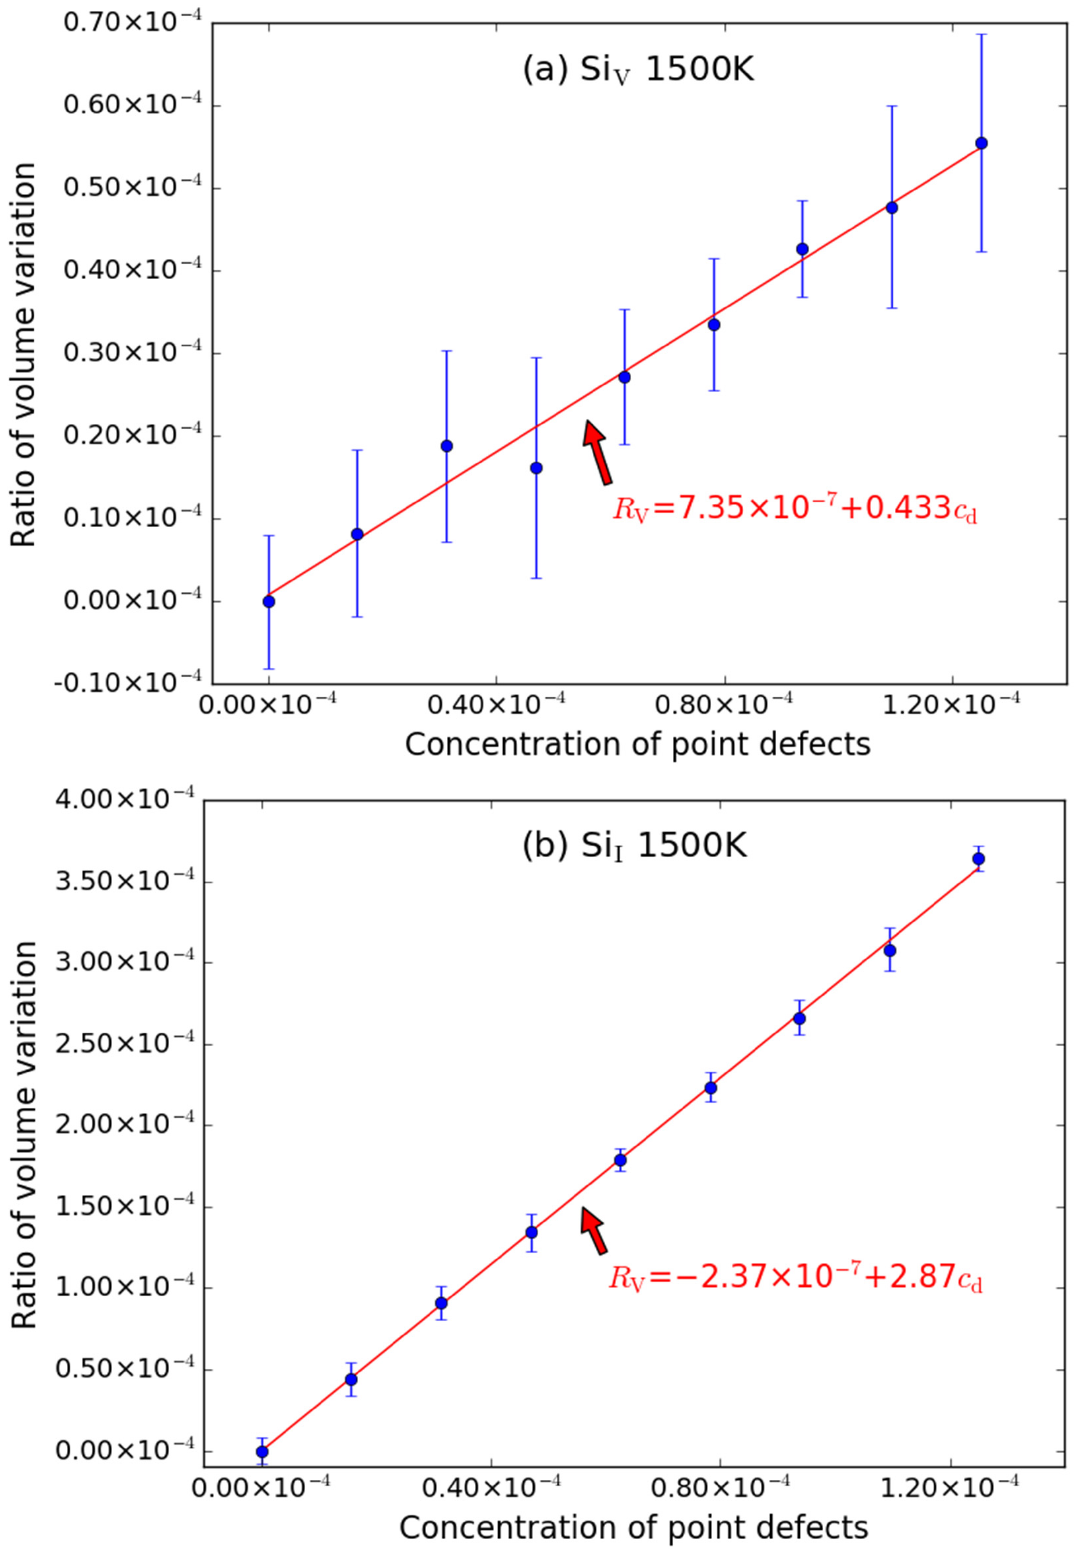
Figure 6. The ratio volume variation ( R V ) of the supercell caused by Si-type point defects (( a ) Si V and ( b ) Si I ) as function of concentrations ( c d ) of point defects at 1500 K. The error bars denote the standard deviations of the values. The size of supercell in MD simulation is 20 a × 20 a × 20 a .